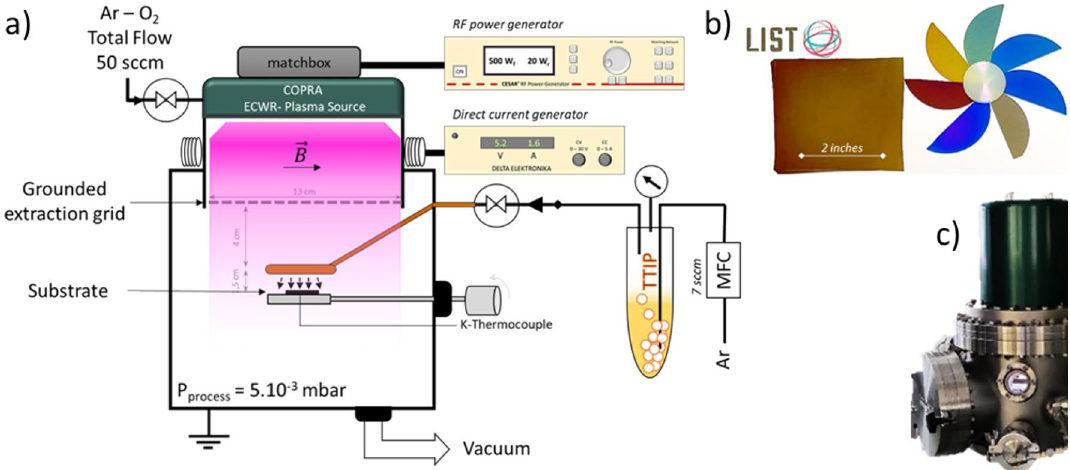
Figure 1. Scheme of the experimental setup of ECWR Plasma process ( a ), TiO 2 thin films obtained with Copra DN 200 CF plasma source for different thickness ( b ) and picture of the source igniting an Ar–O 2 plasma at 500 W ( c